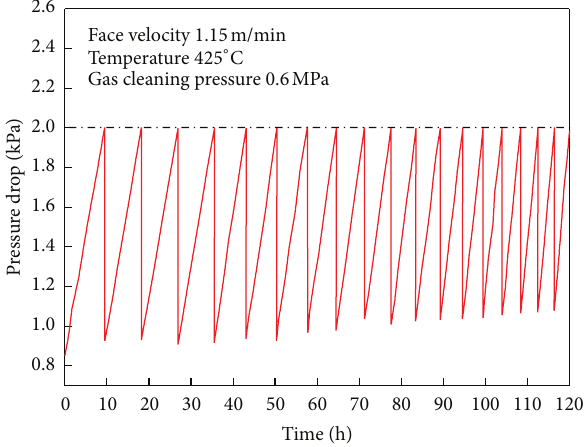
Figure 3: Overall view of the filter vessel.